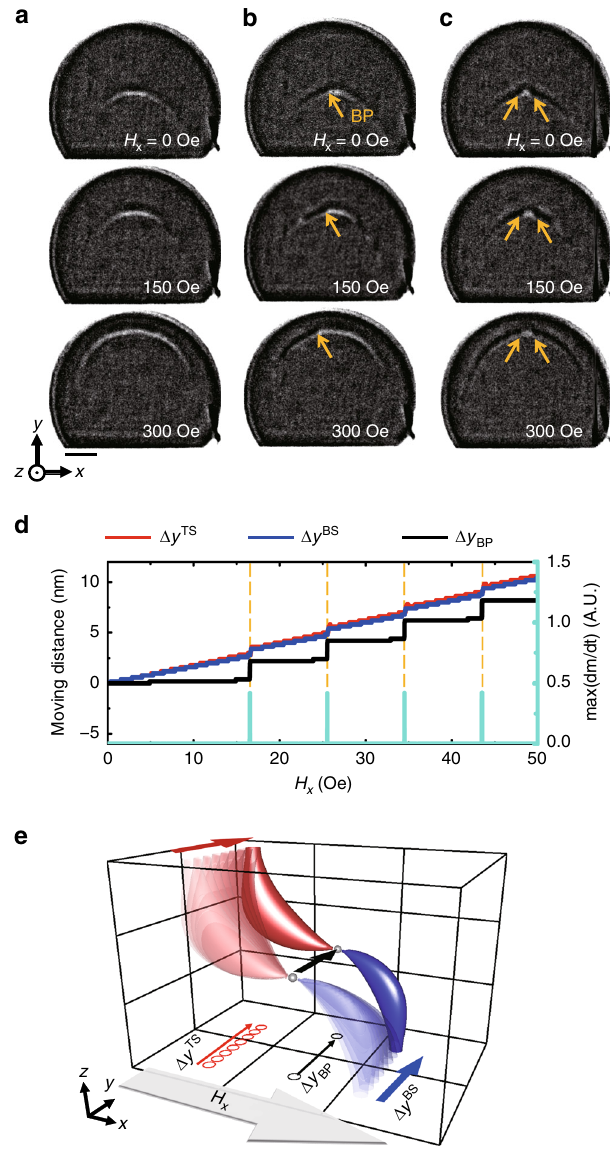
Fig. 3 Quasi-static fi eld-driven motions of Bloch points (BPs). a – c Series of images for BP motions driven by applying an external magnetic fi eld from H x = 0 to + 300 Oe with a fi eld step of 0.5 Oe/ns in the + x- direction observed in the non-BP ( a ), single-BP ( b ), double-BP ( c ) cores at H x = 0, 150, and 300 Oe (scale bar: 500 nm). Damping constant was chosen as α = 0.5 to observe the quasi-static motion of the BP structure as the external magnetic fi eld was slowly increased in the experiment to allow the system to maintain equilibrium. d Relative movements of the vortex cores on the top surface ( Δ y TS , red line) and bottom surface ( Δ y BS , blue line) of the disk, and of the BP ( Δ y BP , black line) along the y -axis together with maximum rates of d m / dt (turquoise line) obtained by the cubic spline interpolation. e Perspective sketch of the quasi-static motions of the vortex cores and BP at the length scale of 0.2